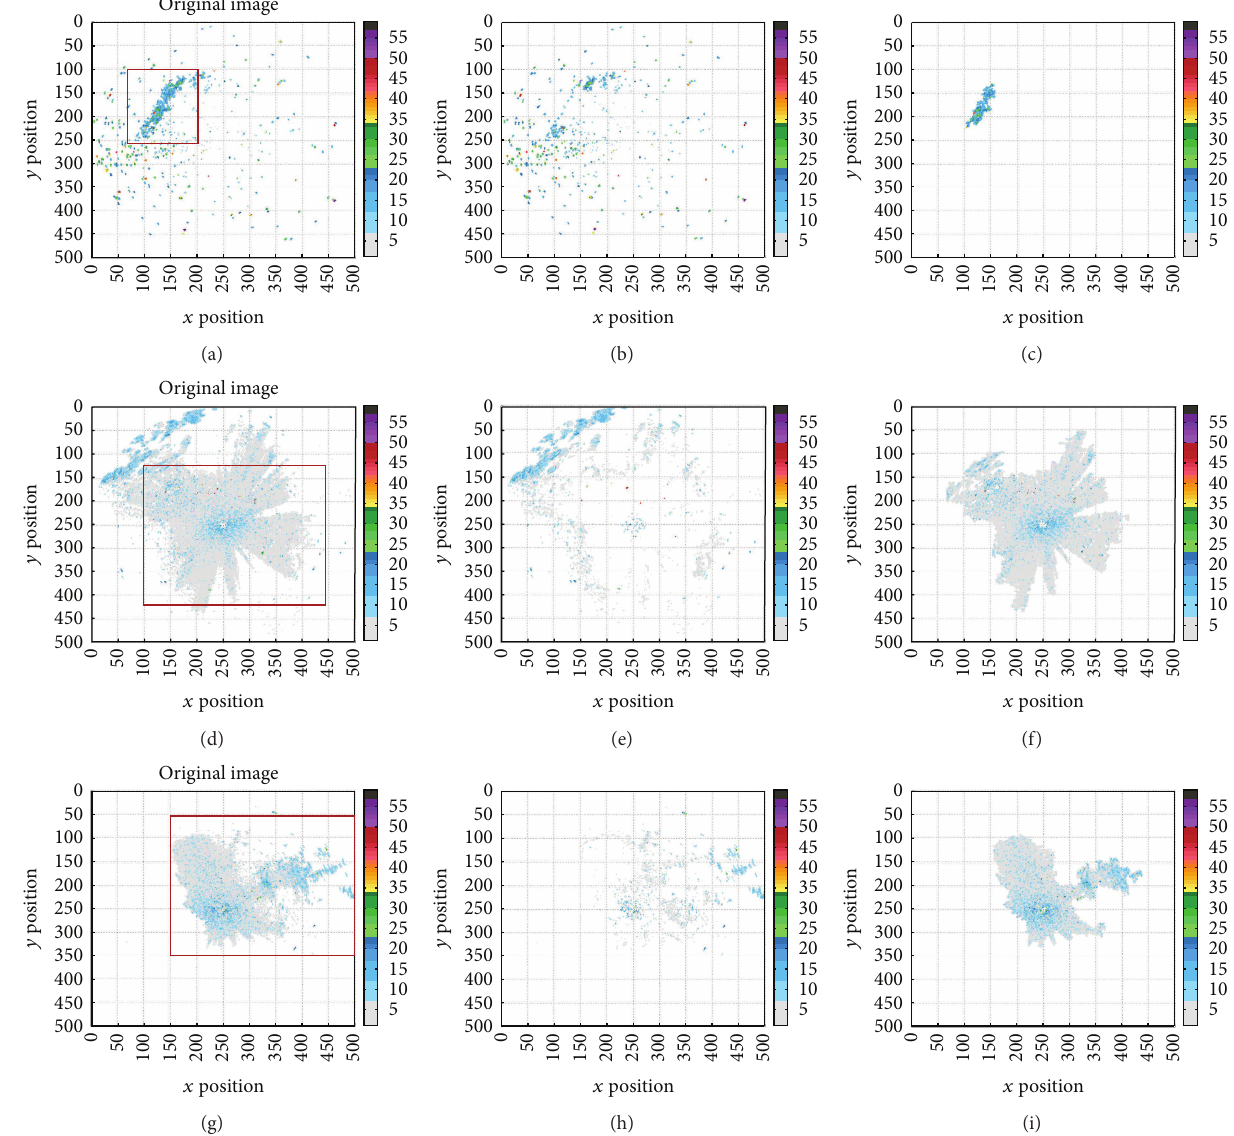
Figure 10: Experimental results: Baekryeongdo radar (a) image of original data, (b) image without anomalous propagation echoes, and (c) image of anomalous propagation echoes; Gwangdeoksan radar (d) image of original data, (e) image without anomalous propagation echoes, and (f) image of anomalous propagation echoes; Gangneung radar (g) image of original data, (h) image without anomalous propagation echoes, and (i) image of anomalous propagation